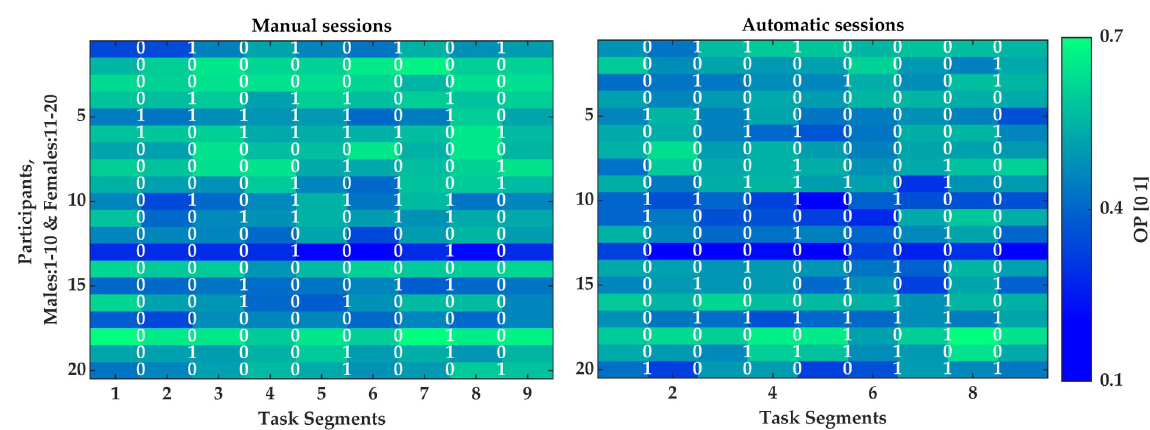
Fig 9. A representation of the overall performance (OP) of each participant (Y-axis) in the manual and automatic sessions. The presence and absence of micro-breaks are indicated respectively by “1” and “0” at the end of each segment (X-axis). The OP is color coded with the color bar indicated on the right side of the graph with blue for lower and green for higher task